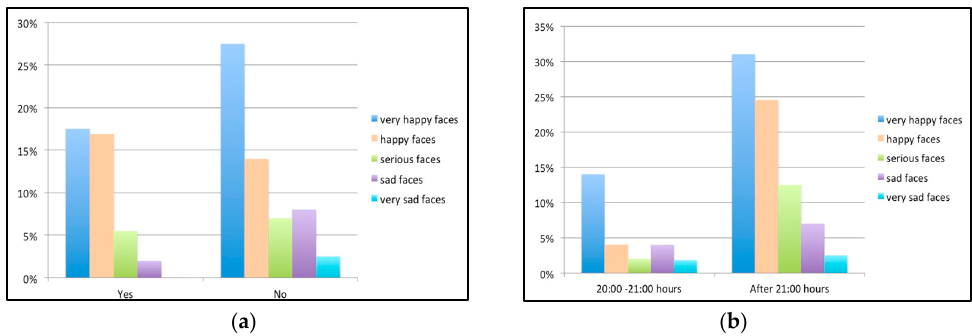
Figure 4. ( a ) Bar chart of the results referring to videogames; ( b ) results referring to